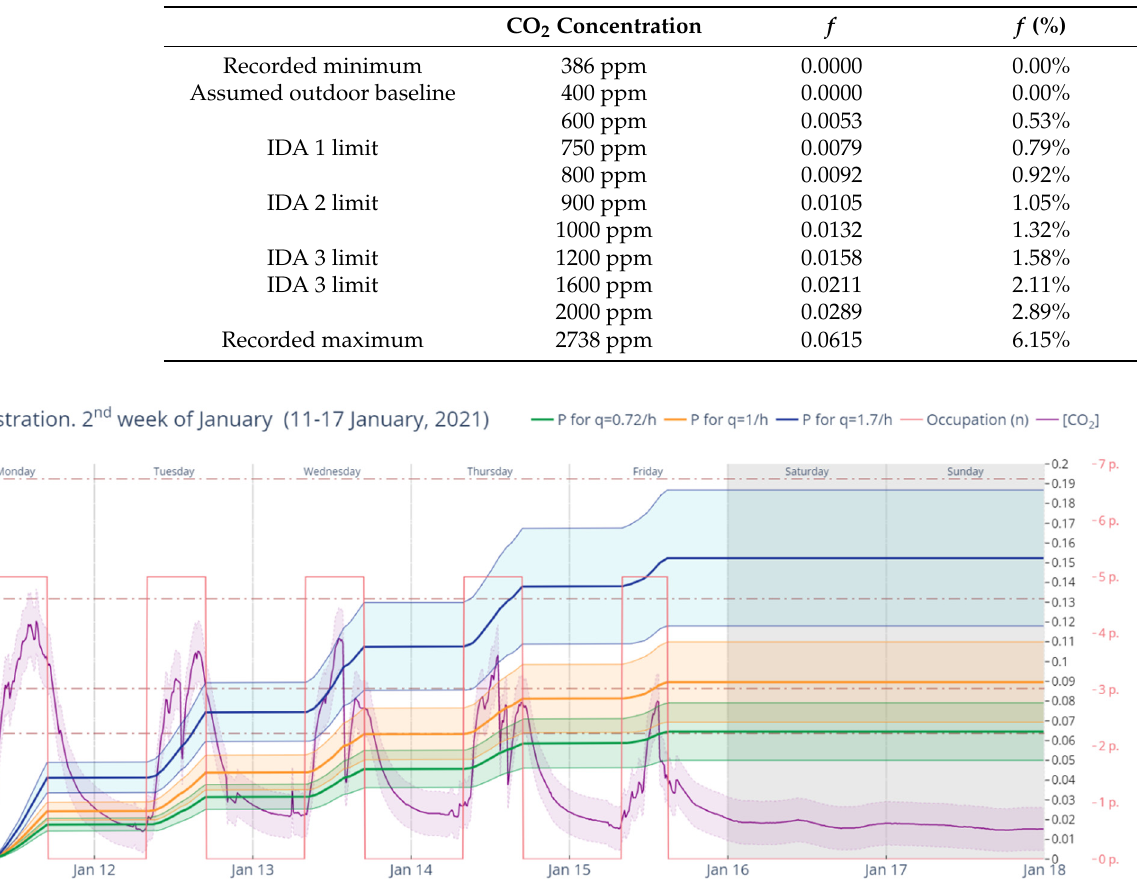
Table 6. Relationship between CO 2 concentration and fraction of rebreathed air in the conditions of the studied spaces.